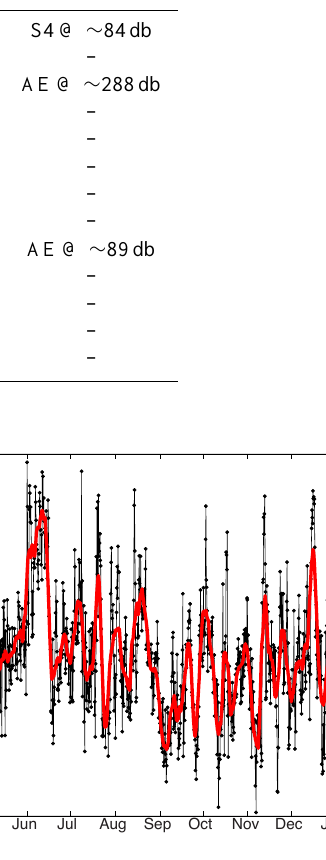
Fig. 3. Time series of Q (dots with black line) for mooring #1 in 2008 with the gravest mode of the Karhunen-Lo´eve transform as a filter (red) being the smoothed version used for the analyses.